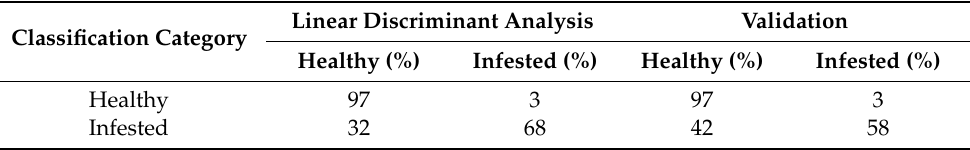
Table 8. Result of plant classification using the linear and logistic discriminant analysis for n =